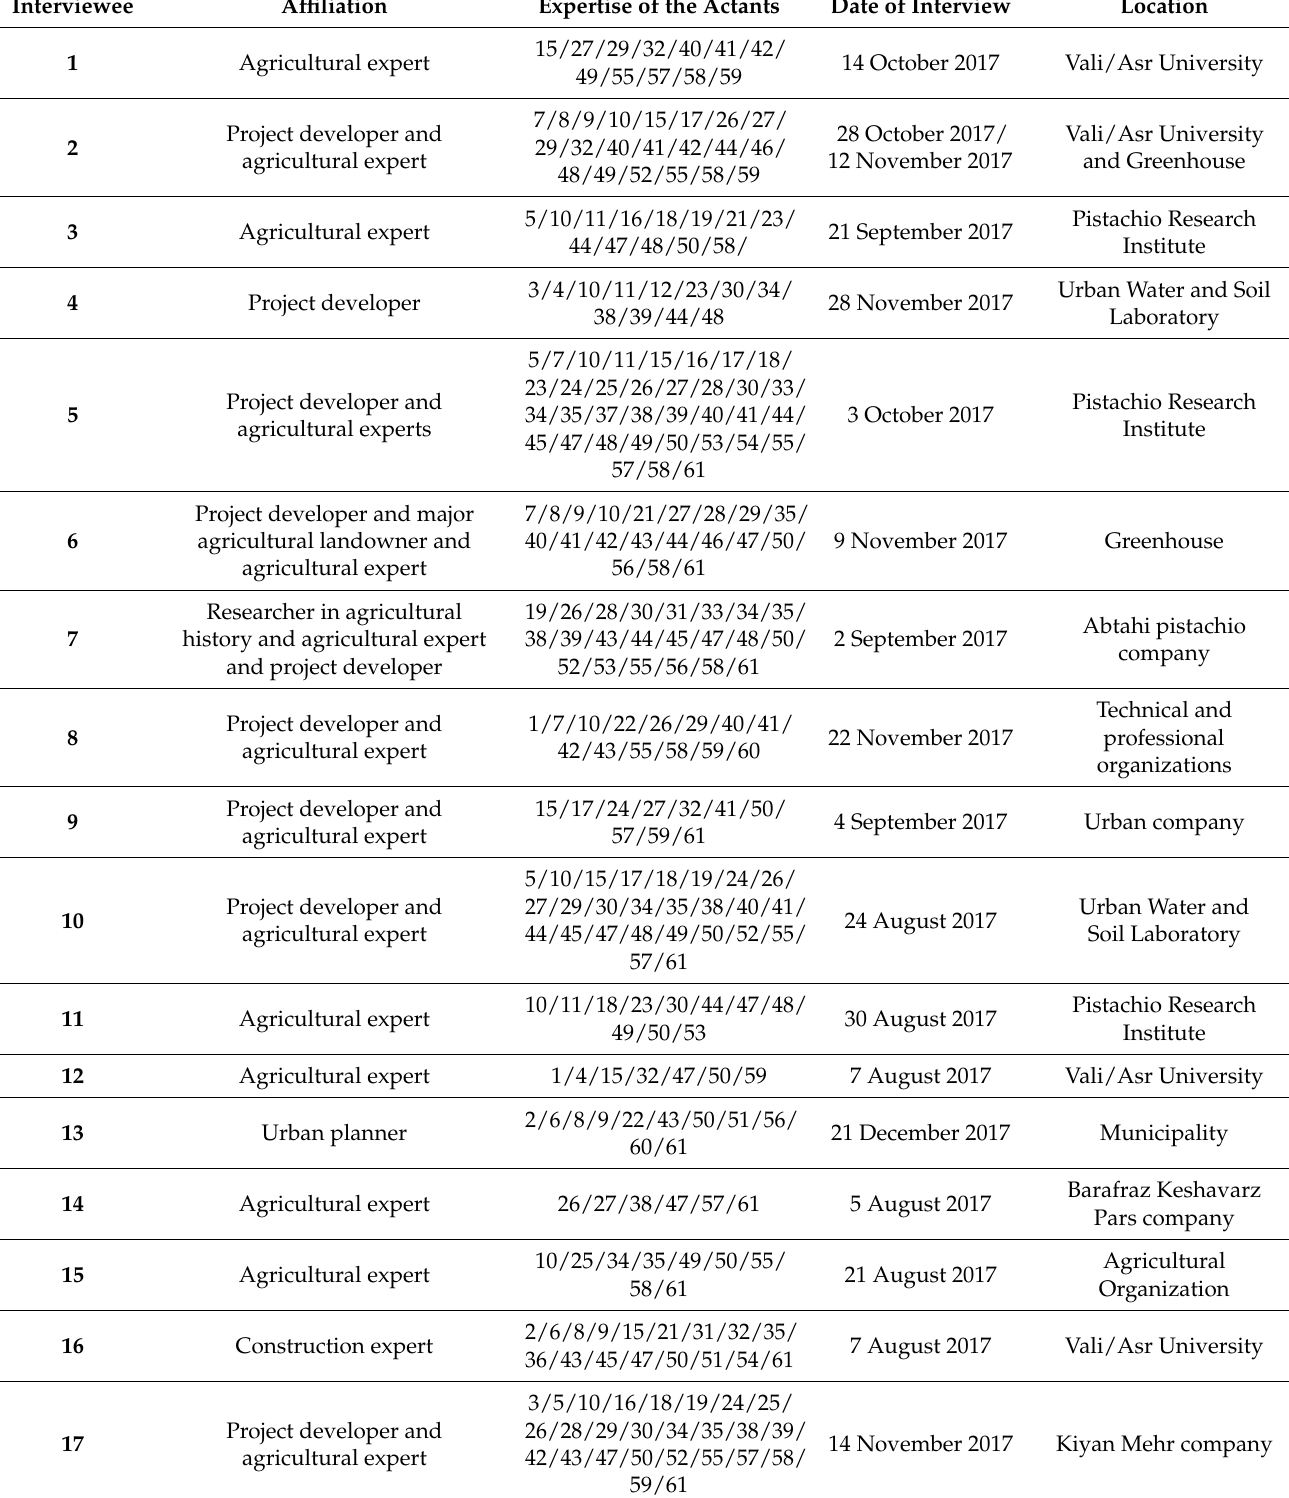
Table A2. List of interviewees in the ANT survey and the actants they are familiar